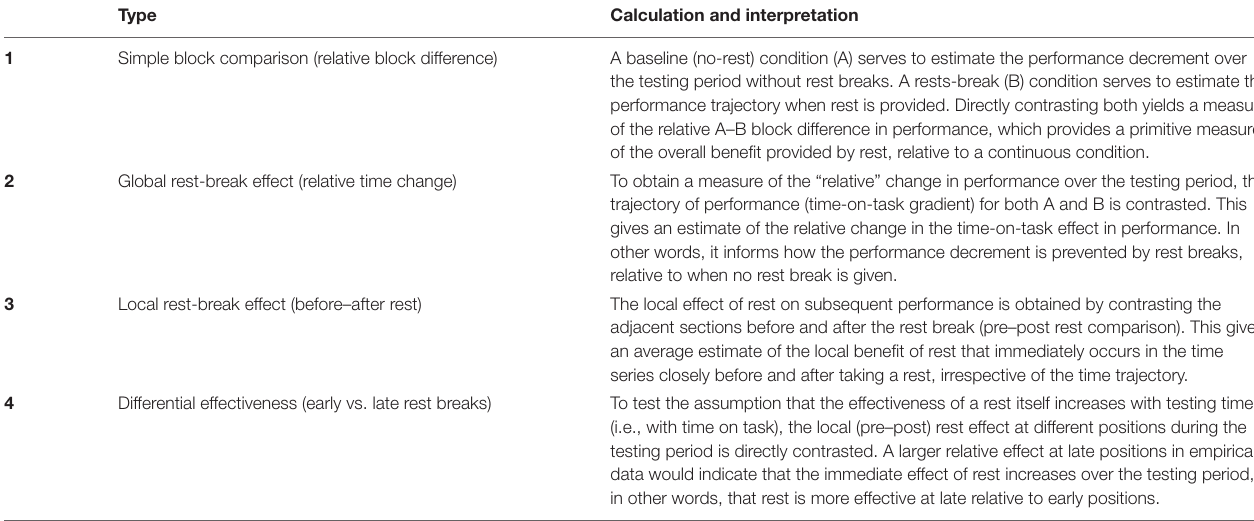
TABLE 3 | Computation and meaning of the four essential contrasts in experimental rest-break designs. Type Calculation and